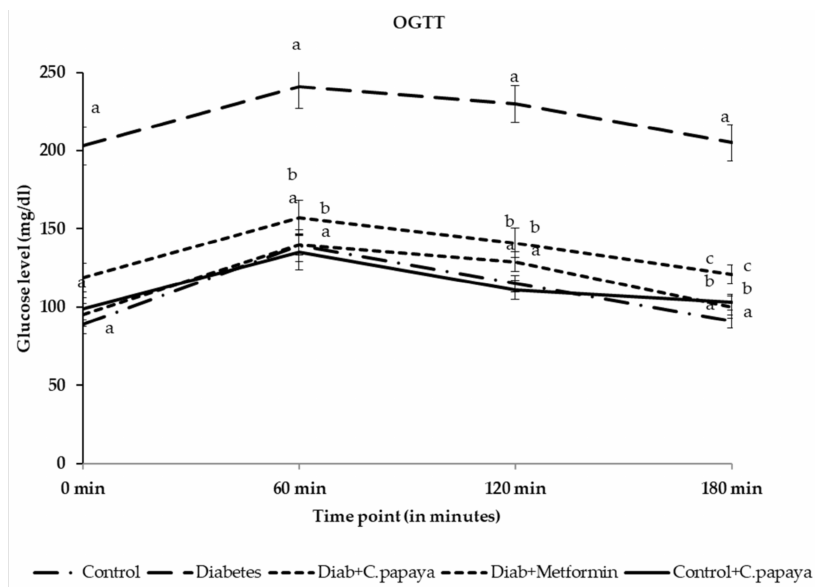
Figure 4. Effect of the ethanolic extract of C. papaya on oral glucose tolerance (OGT) in the control and experimental groups. Each line indicates the mean ± SEM of eight rats, with p < 0.05 indicating significant differences between the groups as: a—control; b—diabetes; and c—diabetic rats treated with the ethanolic extract of C. papaya